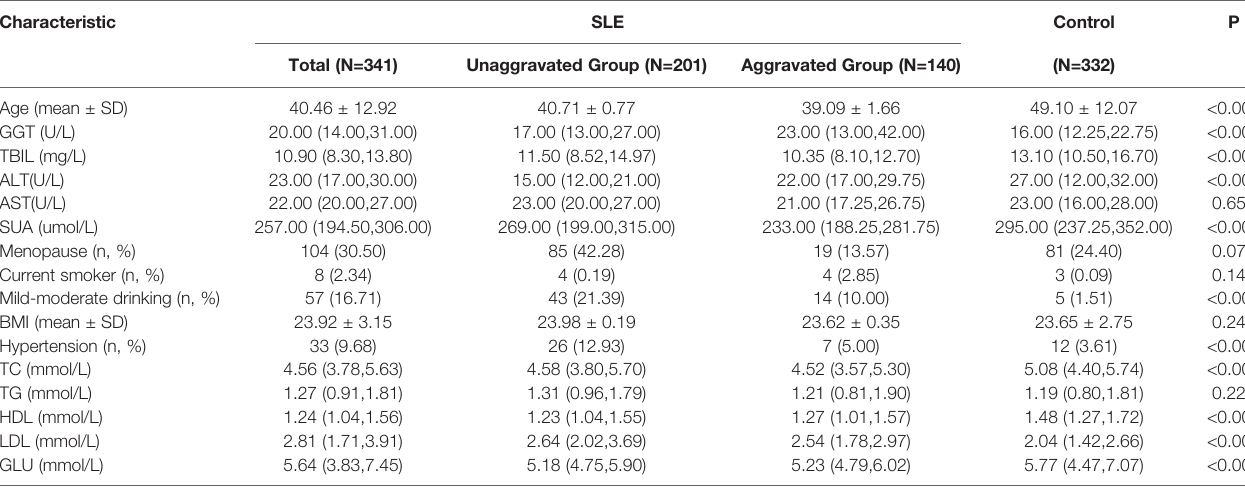
TABLE 1 | Baseline